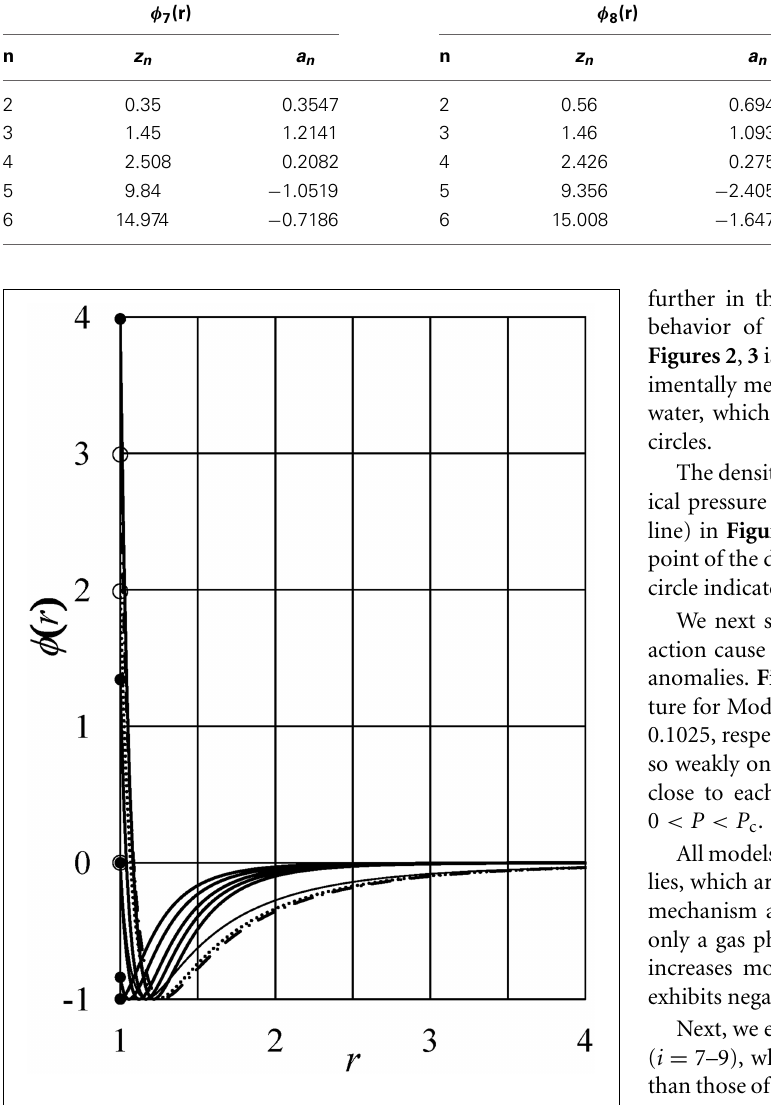
Figure 3 is the same as Figure 2 but at kT 5 = 0 . 390, kT 6 = 0 . 260, kT 7 = 0 . 198, kT 8 = 0 . 177, and kT 9 = 0 . 160. The bin- odal line (thick full line) in the liquid phase has a maxi- mum density ρ = 0.5633 and the lowest density ρ = 0.3615, which ends at the spinodal line. The spinodal line (dot-dash line: ρ = 0 . 3615) in the liquid phase has a minimum pres- sure of P = − 0 . 5196. All isotherms and the binodal overlap with the spinodal on the scale of the figure for gas